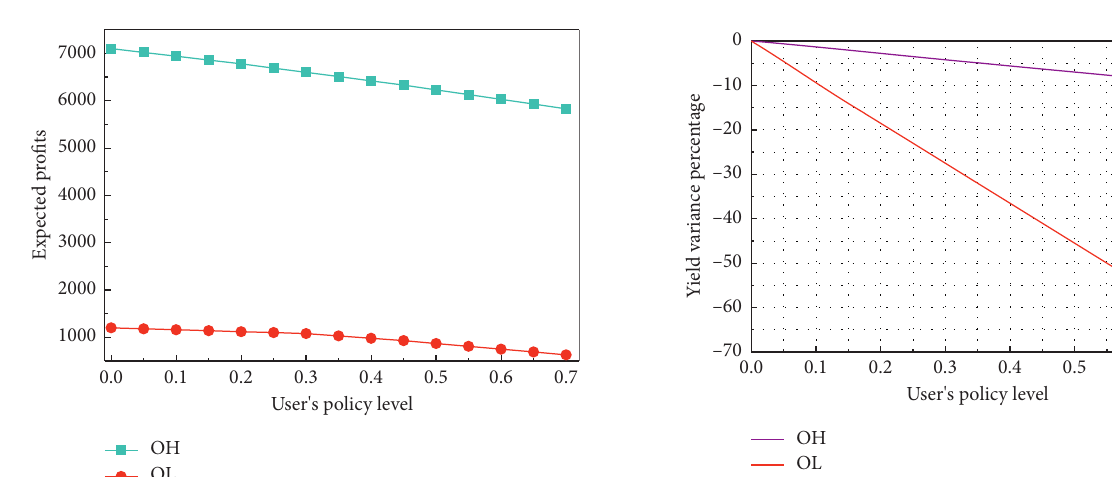
Figure 8: Impact of user’s strategy level on expected equilibrium benefits of community governance.